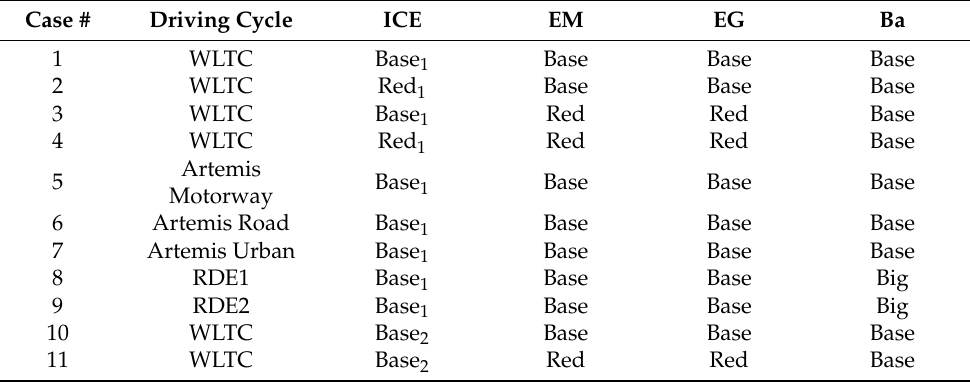
Table 3. Simulation plan.